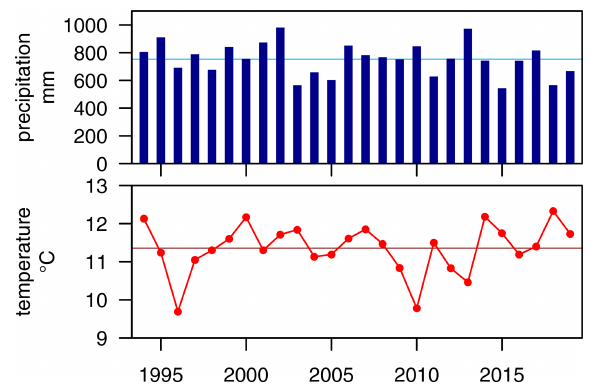
Figure 1. Precipitation and temperature at stations 2522 (January 1994–October 2008) and 4177 (November 2008– December 2019) (DWD Climate Data Center (CDC),